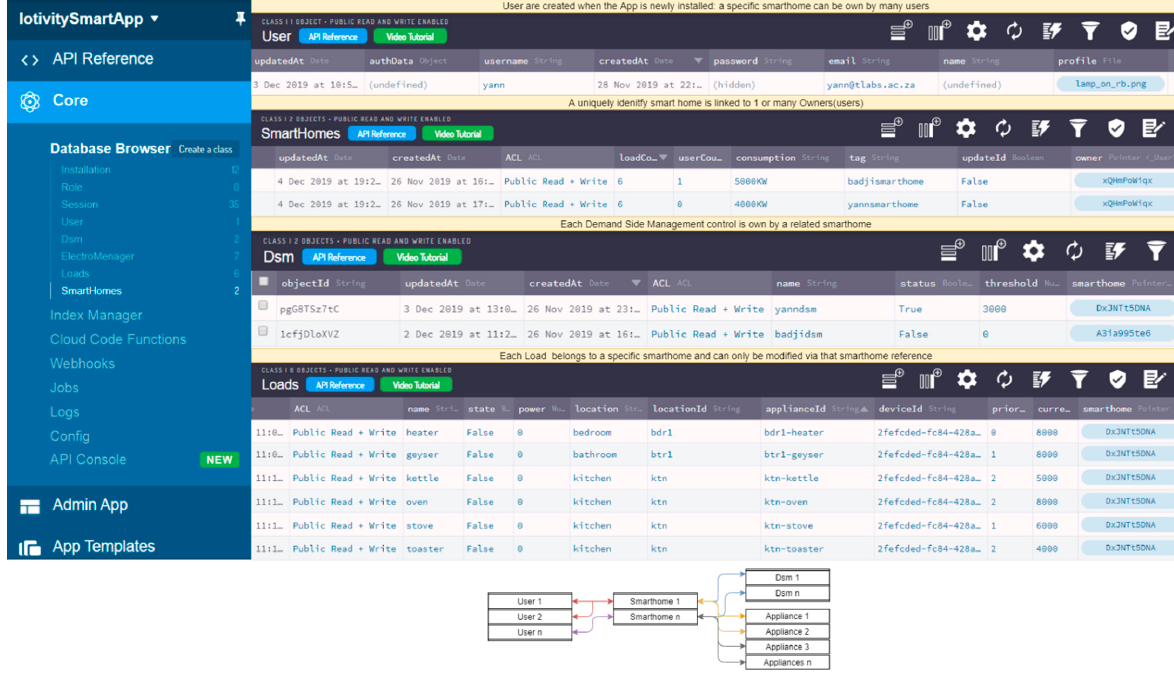
Figure 3. Platform databases structure and connections on Back4App BaaS .